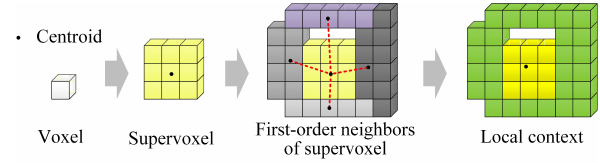
Figure 3. Local context of the supervoxel.